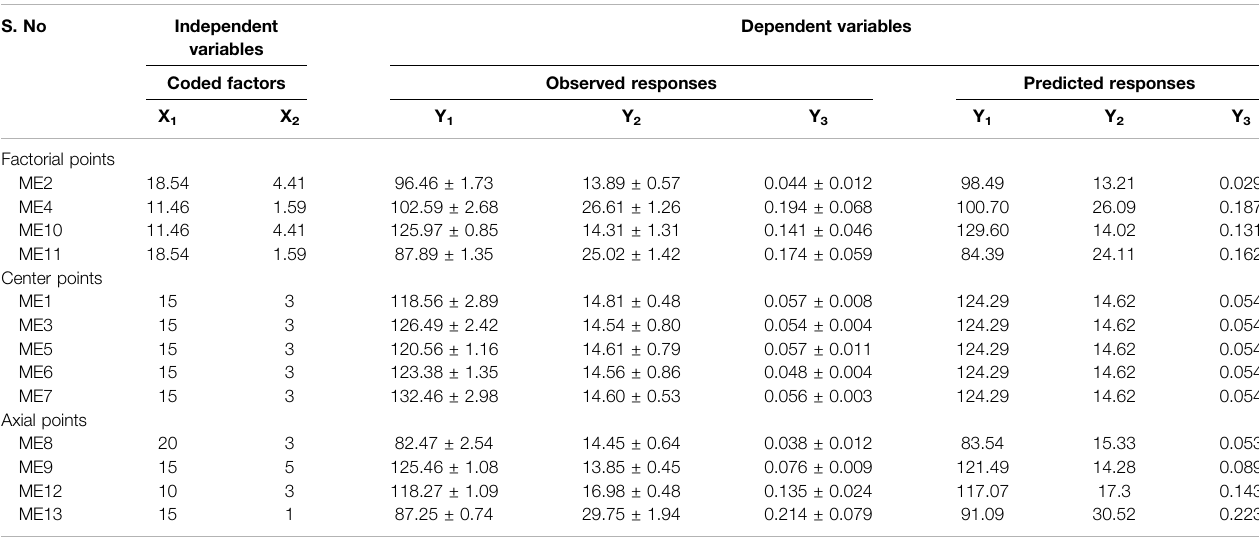
TABLE 5 | Effect of independent variables on dependent variables.